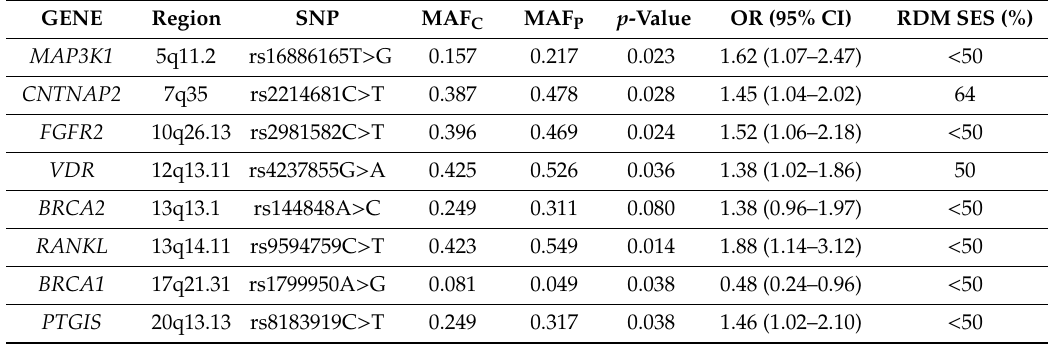
Table 1. Analysis of individual SNPs using logistic regression adjusted for age, BMI, and individual European ancestry, and randomized sub-sampling.